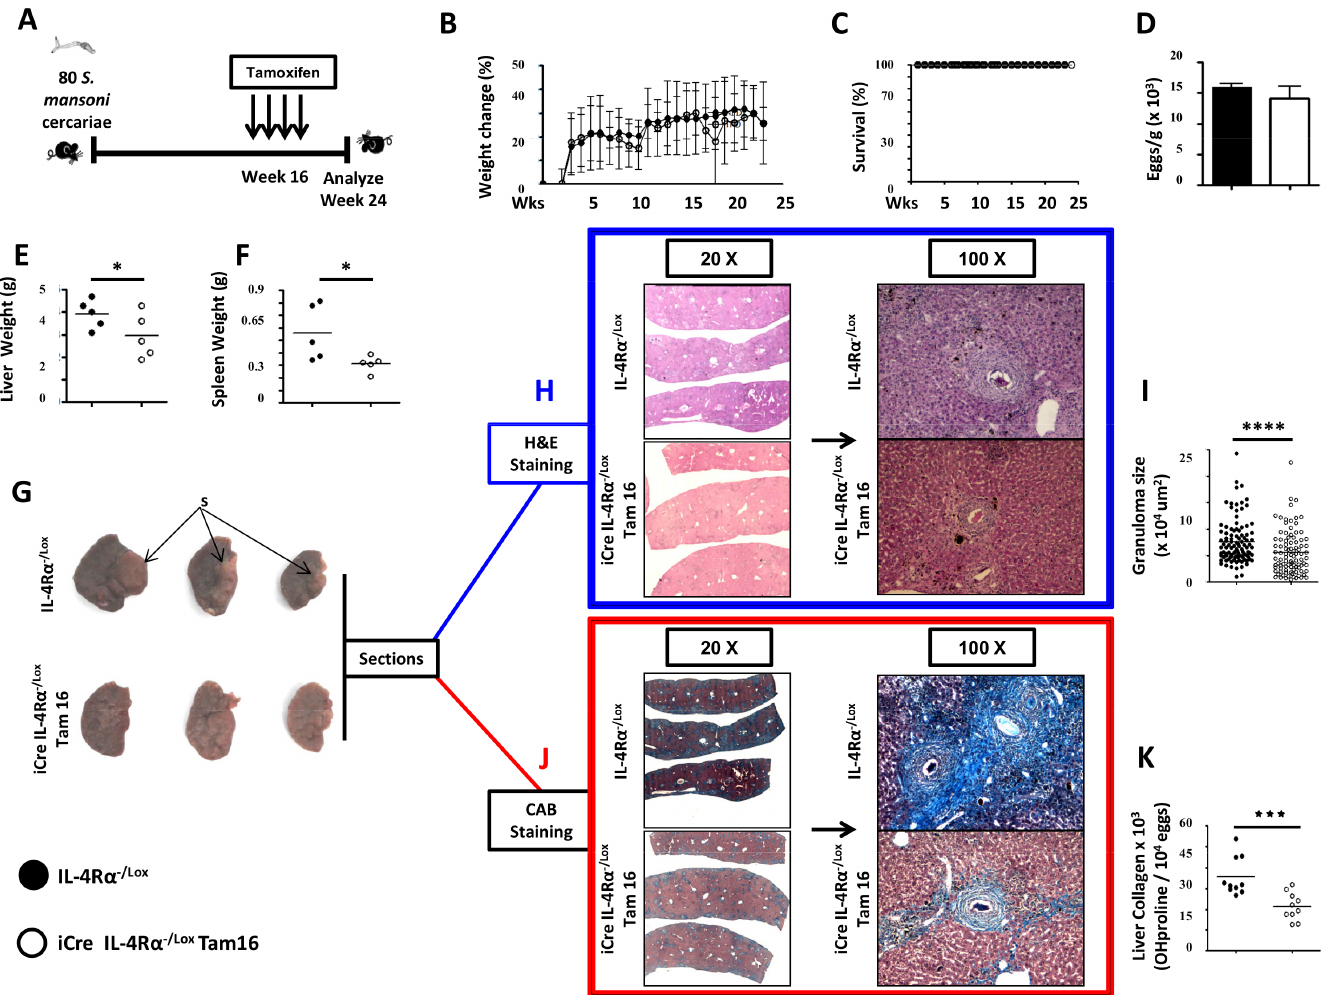
Fig 6. Histopathological profile of S . mansoni- infected mice after knocking down IL-4R α 16 weeks post-infection. A. Experimental design. B. Body weight changeover time following S . mansoni infection. C. Survival curve over 24 weeks following S . mansoni infectionand IL-4R α knockdown 16 weeks post-infection. D. Liver egg burden. E. Liver weights. F. Spleenweights. G. Representative photographsof liver lobes from mice infected for 24 weeks with S . manson iwith and without IL-R α signalinginterruptionat week 16. Note the formed acellularscar-likestructure (S) in the livers of control mice. H. Formalin-fixed sections of the liver lobes were performed and stained with Hematoxylin/Eosin (H&E). I. Area size of egg-surrounding granuloma computedfrom H&E stainedsections. J. Formalin-fixed sectionsof the liver lobes were stained with CAB for collagendetection(in Blue). (